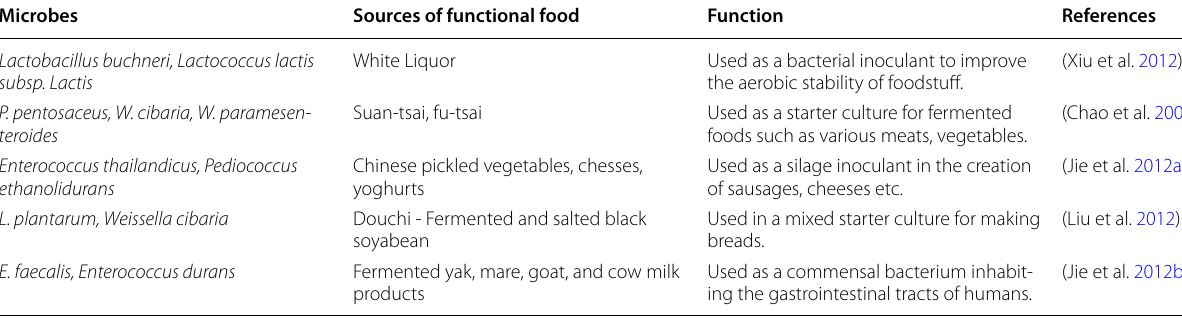
Table 2 List of Microbes used in functional foods and its benefits Microbes Sources of functional food